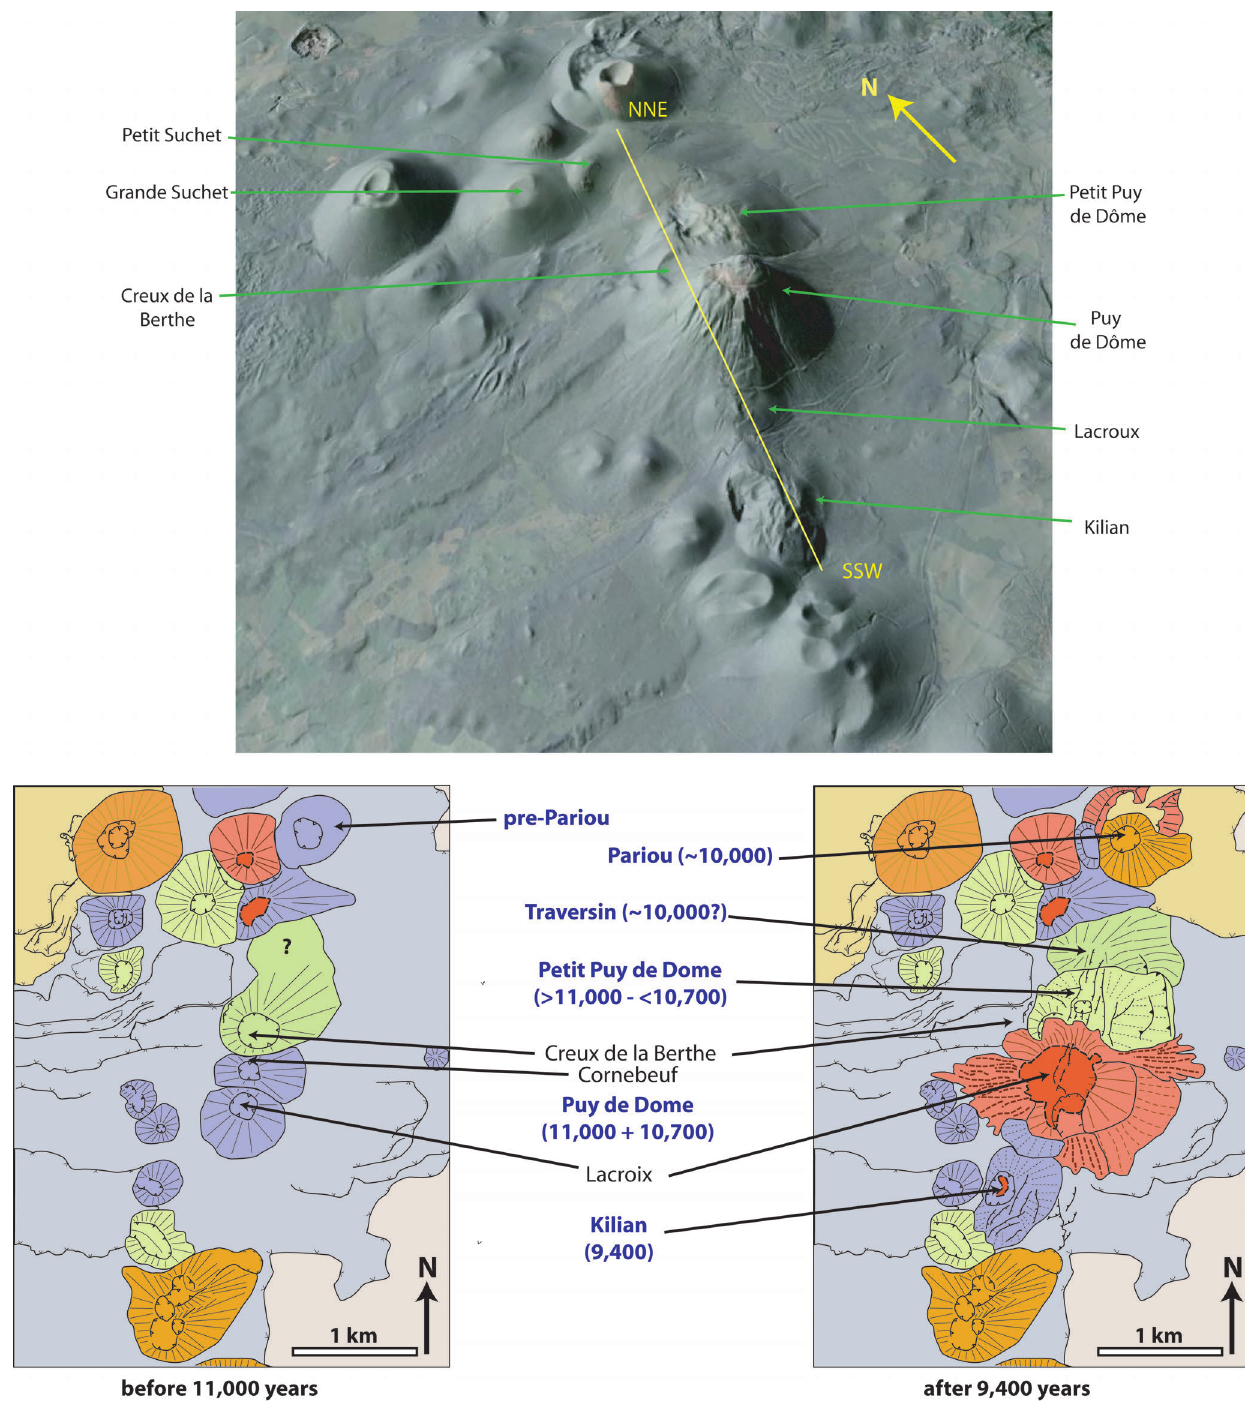
Figure 13: History of the Puy de Dôme area. [A] Oblique image of LiDAR-derived shaded relief (CRAIG dataset), overlain on the Google Earth image of the Puy de Dôme area. Line of cross section in Figure 14 shown in yellow. [B] Map of the area up to 10,000 years before the start of the Petit Puy de Dôme intrusion. [C] Map after 9,400 years (e.g. like in Figure 2), with the newly appeared volcanoes and structures indicated. Compare this diagram with the cross-sections in Figure